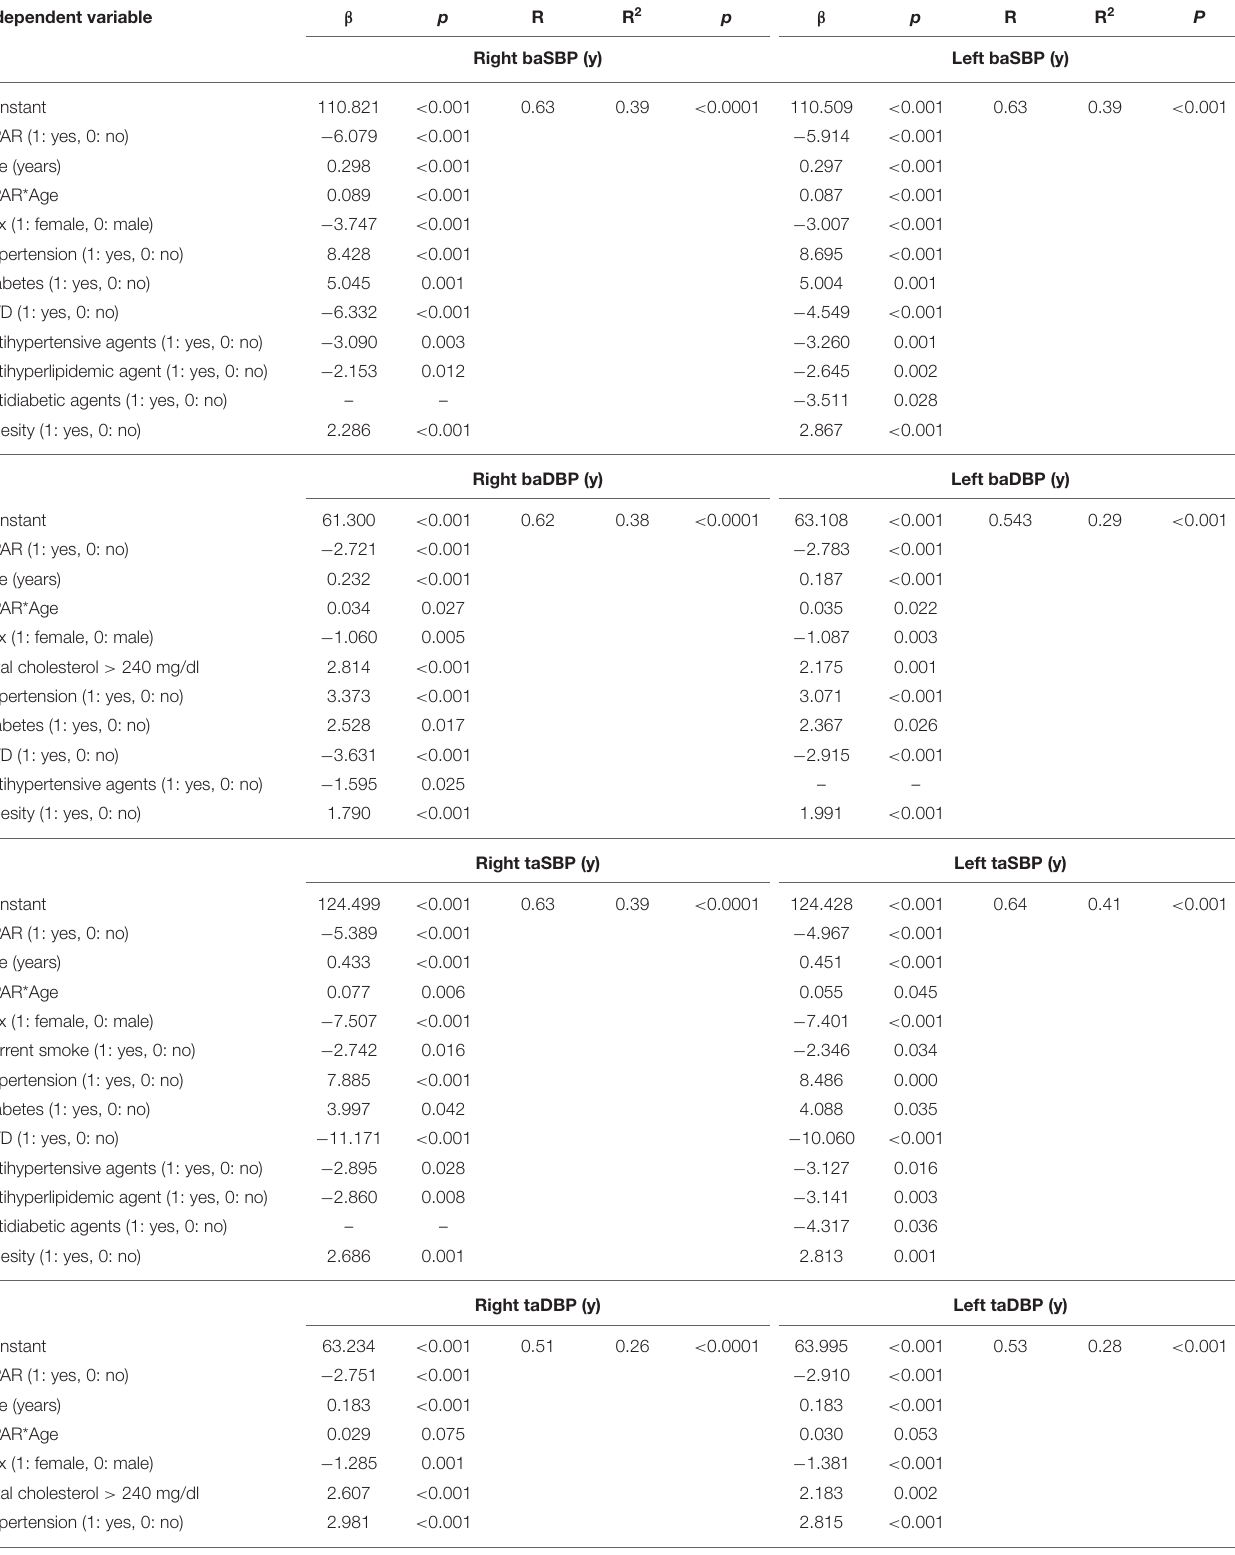
TABLE 4 | Association between CPARs and ankle brachial index, with age as a moderating variable. Independent